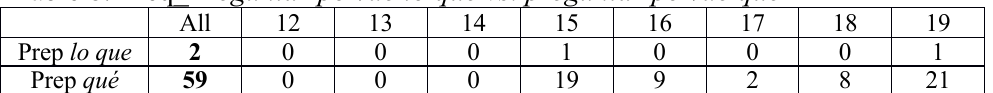
Table 8: Freq_ Preguntar por/de lo que vs. preguntar por/de qué